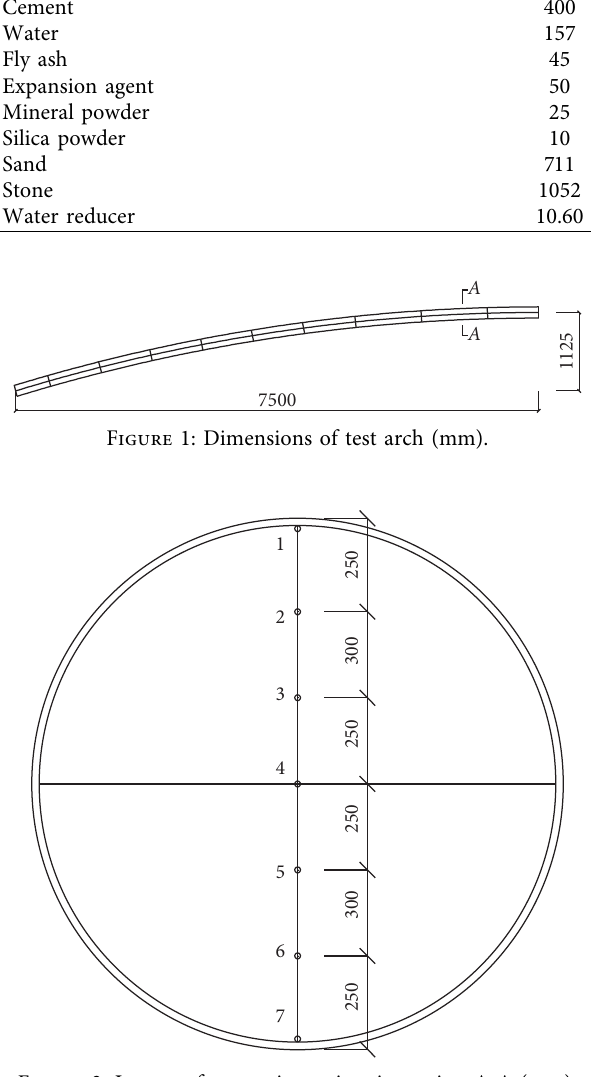
Figure 2: Layout of measuring points in section A-A (mm).